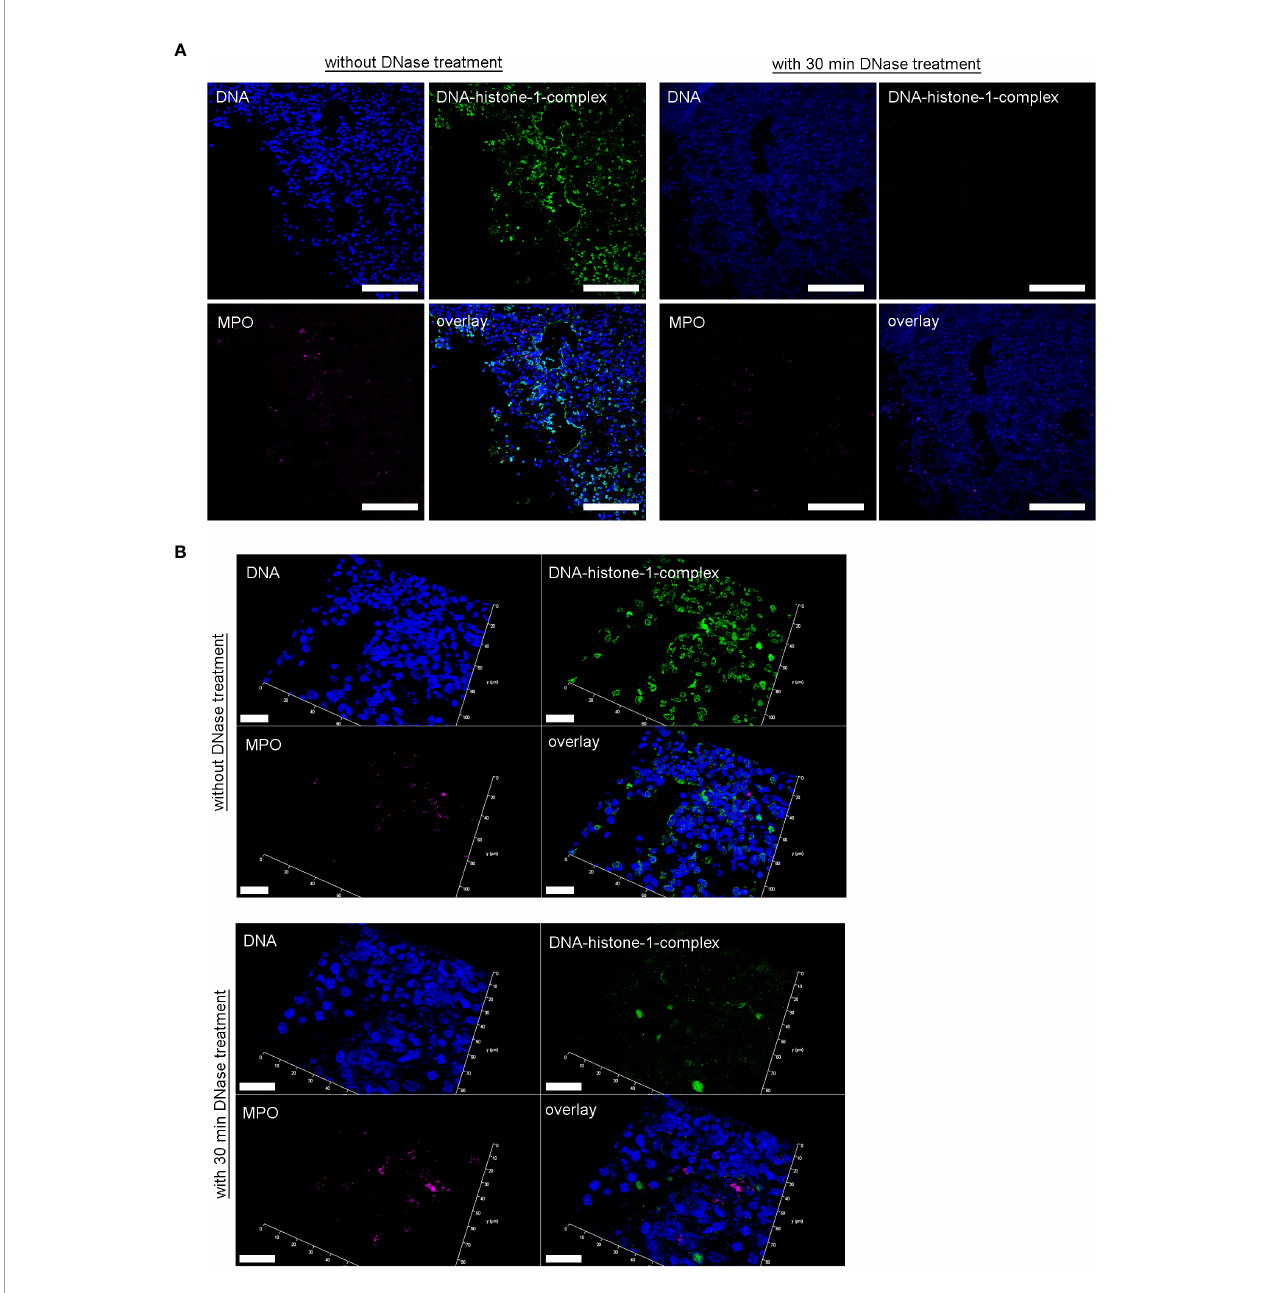
FIGURE 5 | DNase treatment of 30 minutes delete the DNA-histone-1-complex from lung sections, but not the myeloperoxidase. (A) Serial cuts of lungs from SARS-CoV-2 infected hamsters were treated during the NET-staining with and without DNase for 30 minutes at 37°C. The settings were adjusted to a respective isotype control (with and without DNase treatment). (B) Representative 3D images of z-stacks from the same localization in two serial cuts (with and without DNase treatment) were constructed with LAS X 3D Version 3.1.0 software (Leica) (upper panel: 4.36 µm consisting of 27 sections, lower panel: 6.55 µm consisting of 40 sections). Representative images are presented (blue = DNA, green = DNA-histone-1-complex, magenta = MPO). Scale bars in (A) = 100 µm, in (B) =